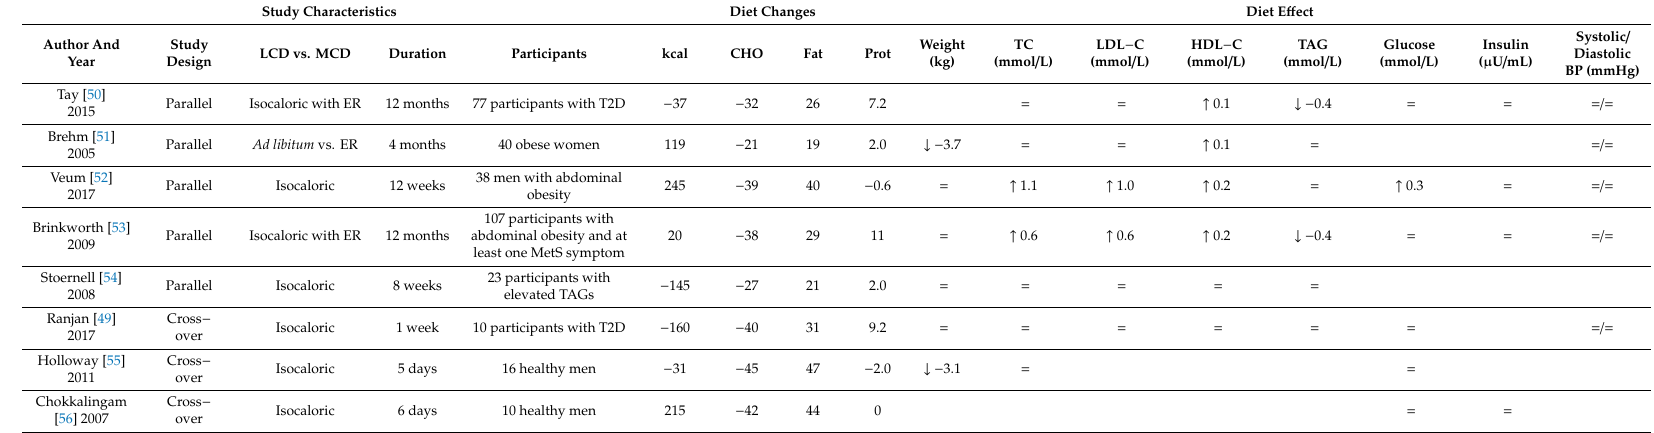
Table 3. Overview of the very low-carbohydrate diets ( < 30–3 E%) and their e ff ects on cardiometabolic risk